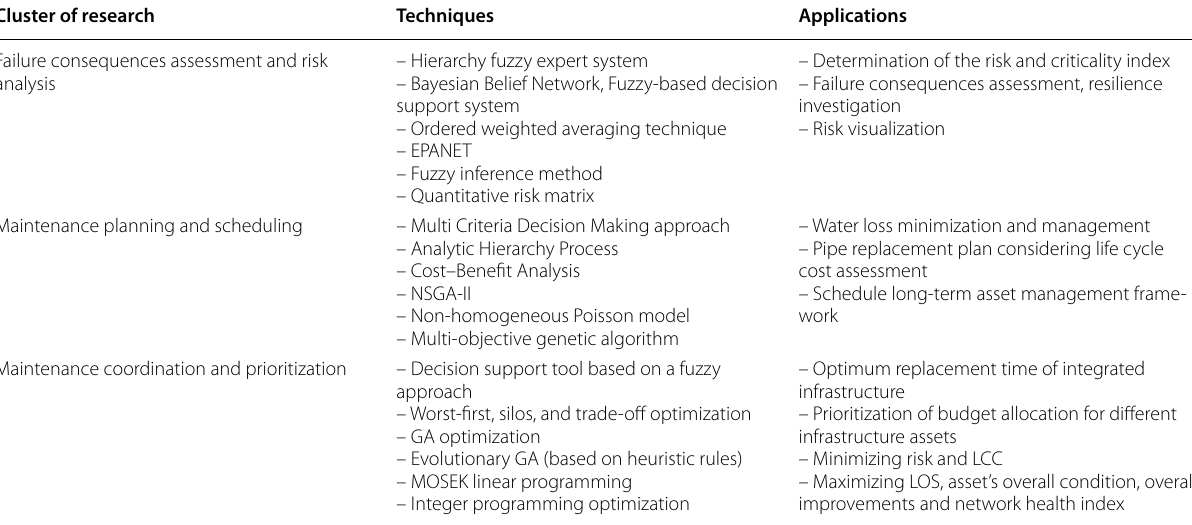
Table 2 A summary of prescriptive analytics applications for water pipes failure Cluster of research